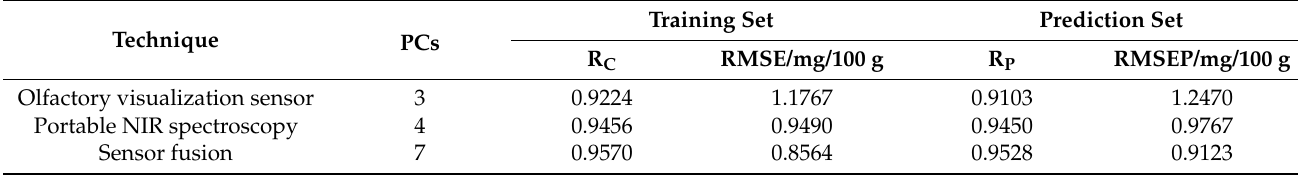
Table 2. The performance comparisons of different BPNN